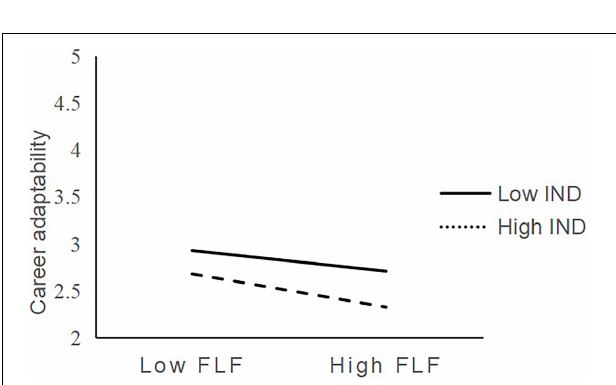
FIGURE 3 | Interaction of fear of losing face and indecisiveness predicting career adaptability.